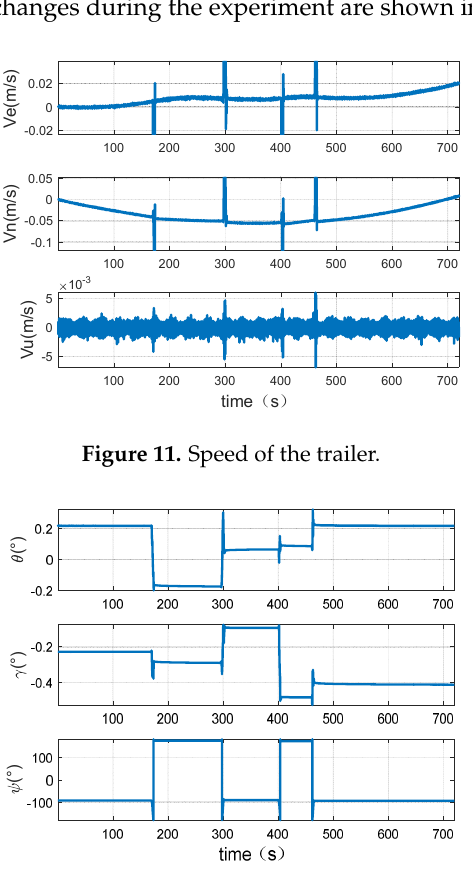
Figure 12. The attitude change of the trailer.